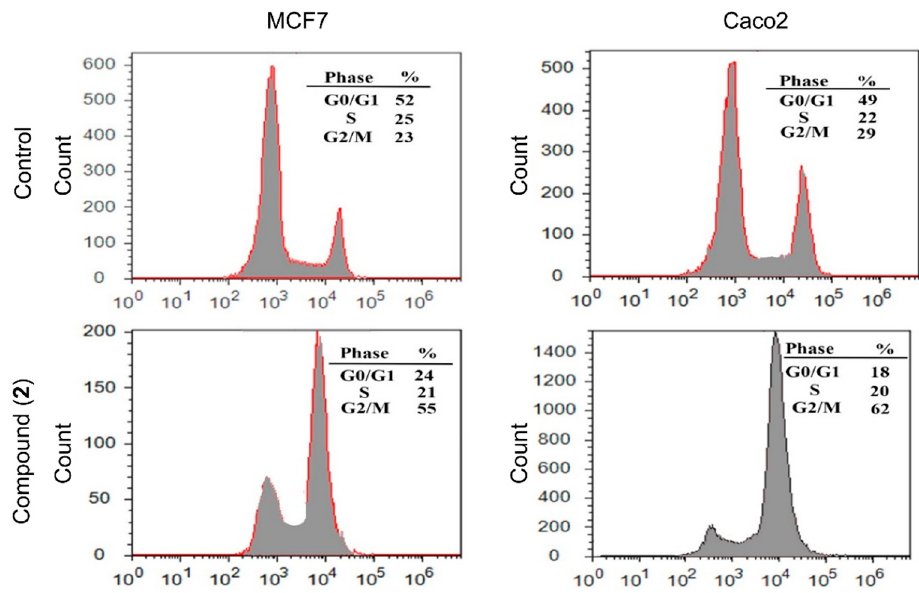
Figure 6. Effect of compound ( 2 ) on % of cells in the three cell-cycle phases of MCF7 and Caco2 cells as measured by flow cytometry. The x -axis represents the propidium iodide (PI) fluorescence based on the DNA content and the y -axis represents the number of cells in each phase.